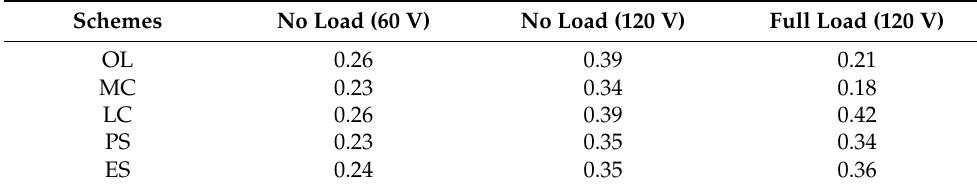
Table 4. THD (%) values under different schemes in the simulation.